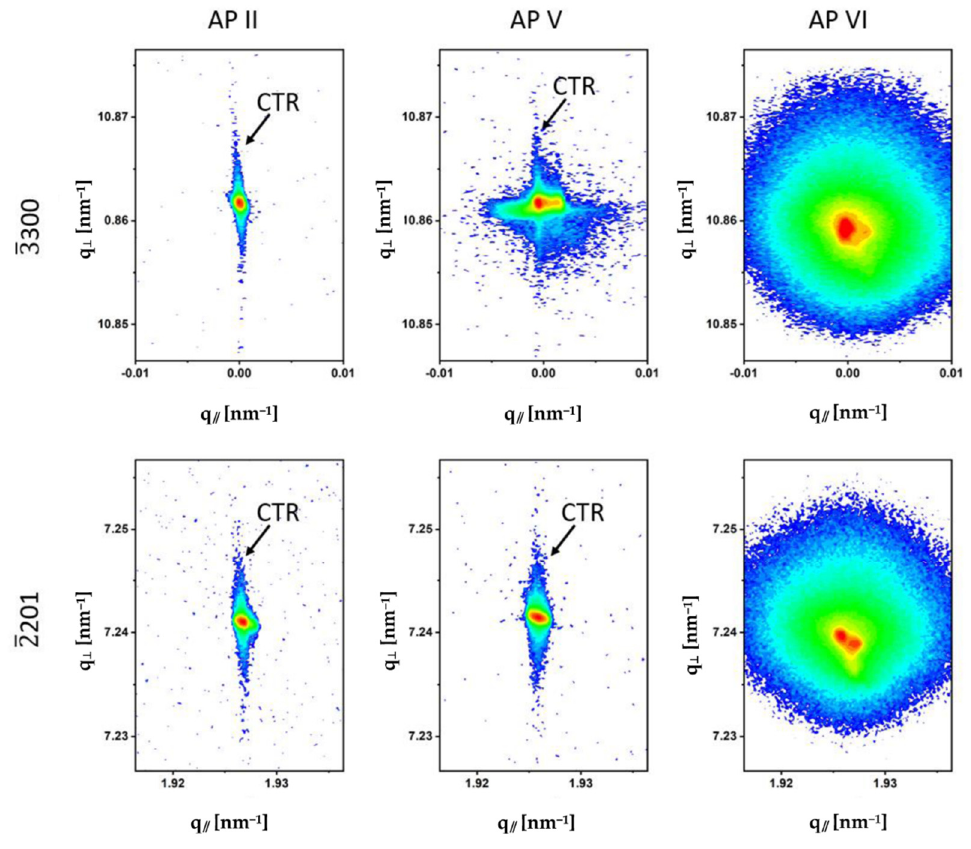
Figure 9. RSMs of the symmetrical 3300 reflection and the asymmetrical 2201 reflection performed on the 1100 slice. Positions of the crystal truncation rods (CTR) are indicated on the maps. For this reason, the results of the RSMs of the a -plane and m -plane samples are de- scribed together. The AP IIs were located in region (4) of the newly grown Am-GaN in the [0001(cid:3364)] direction, the AP Vs were from region (2) of the crystal where the first growth phase occurred and the (0001(cid:3364)) plane was recovered, and the AP VIs belonged to the lat-